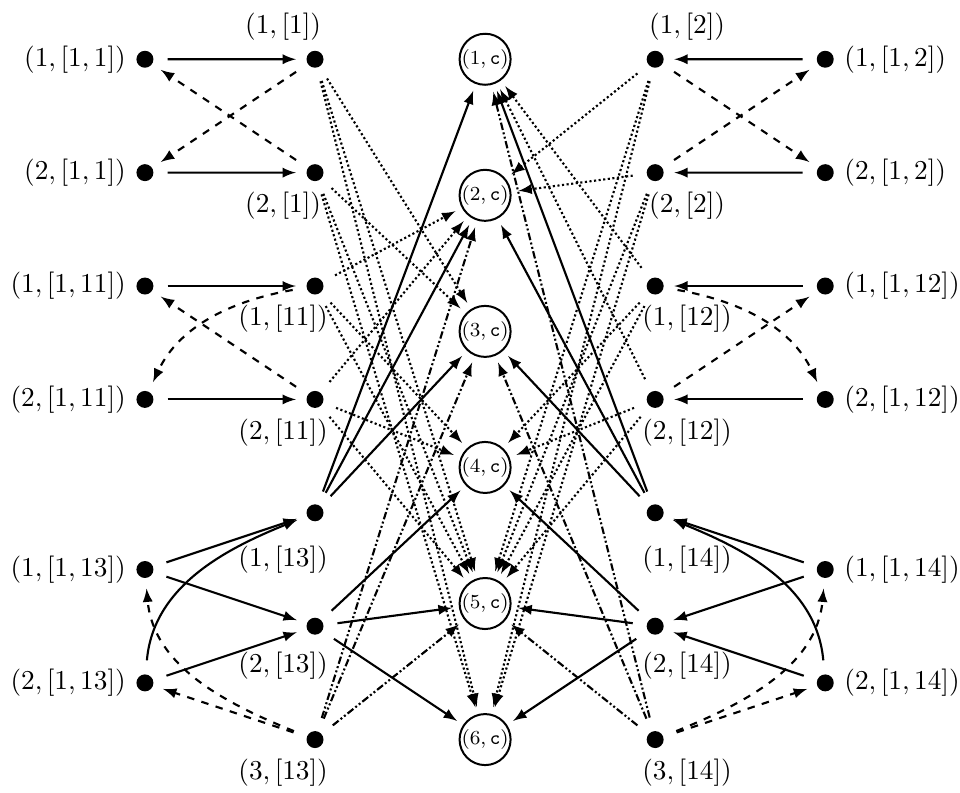
Figure 7: Partial orientation D for H for s = 6, k =